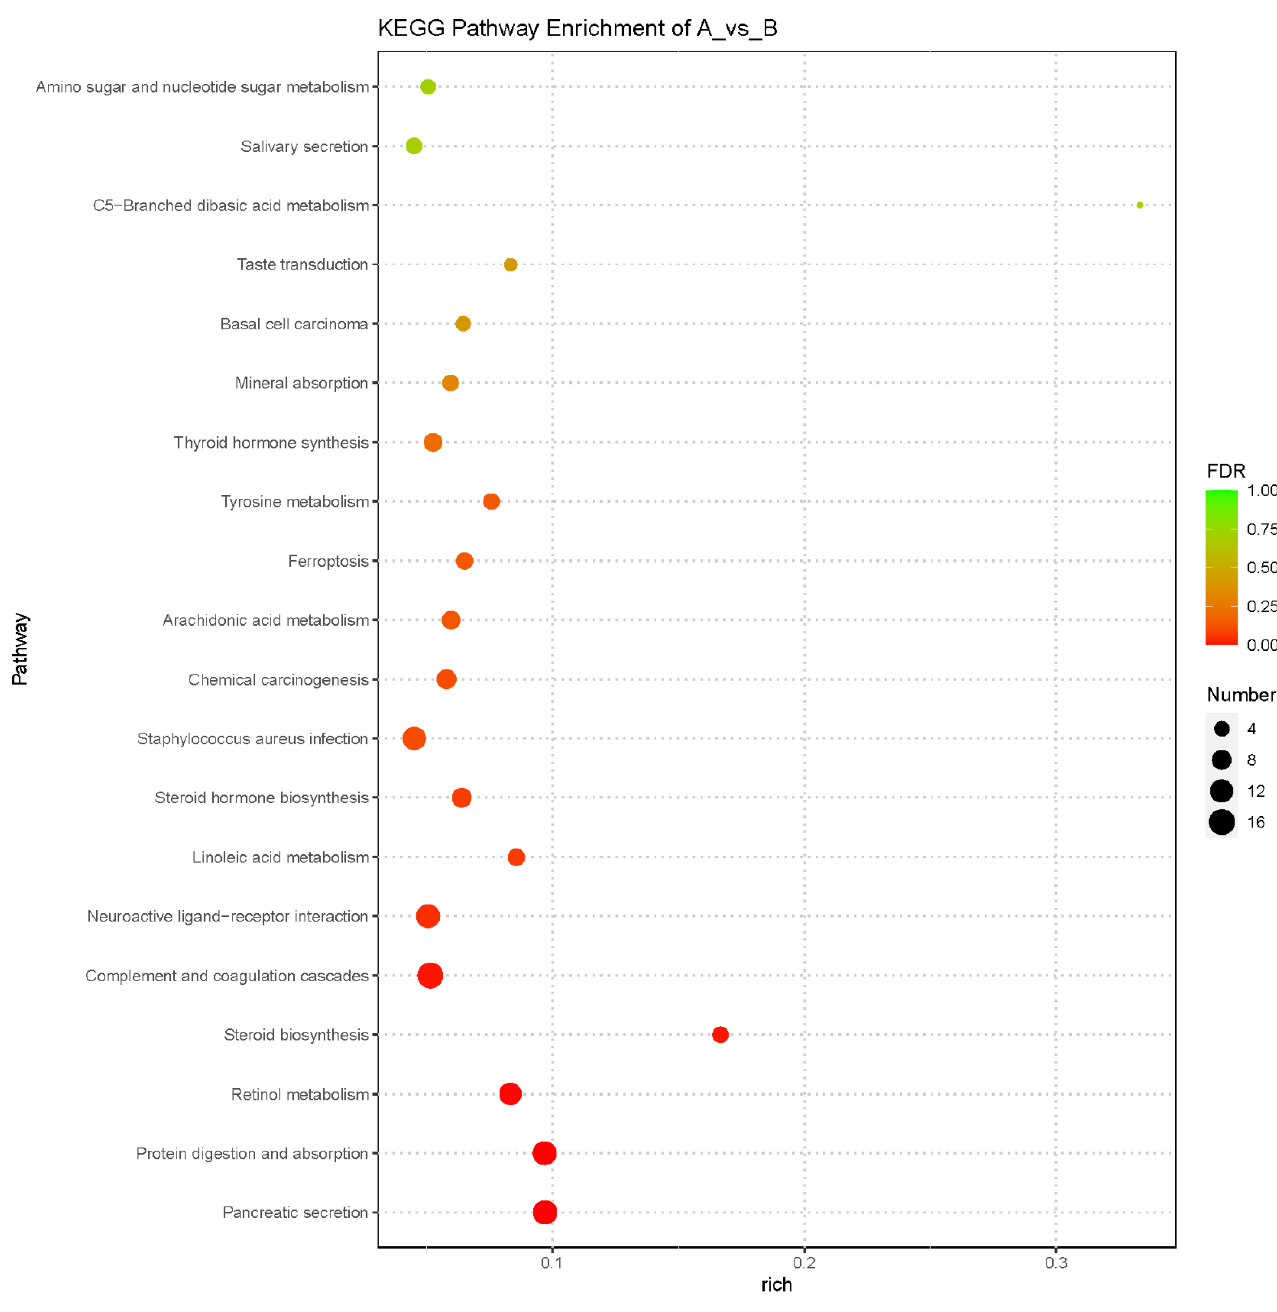
Figure 5. KEGG (Kyoto Encyclopedia of Genes and Genomes) pathway analysis of differentially expressed genes. The X -axis represents rich factor and the Y -axis represents pathways. The color and size of each bubble represent the enrichment significance and the number of genes enriched in the pathway, respectively. (For interpretation of the references to color in this figure legend, the reader is referred to the web version of this article).